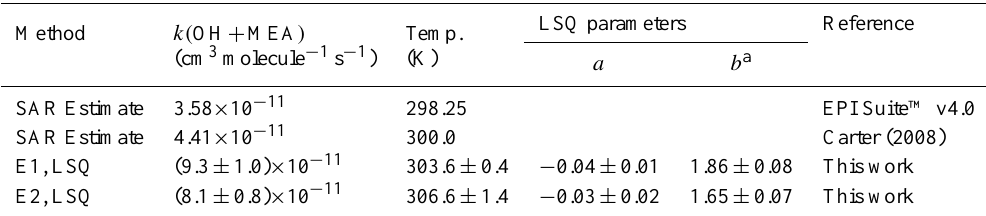
Table 6. Rate constant k( OH + MEA ) values estimated by SAR and as determined in Experiment E1 and E2. LSQ parameters and their uncertainties are provided for the experimentally derived rate constant